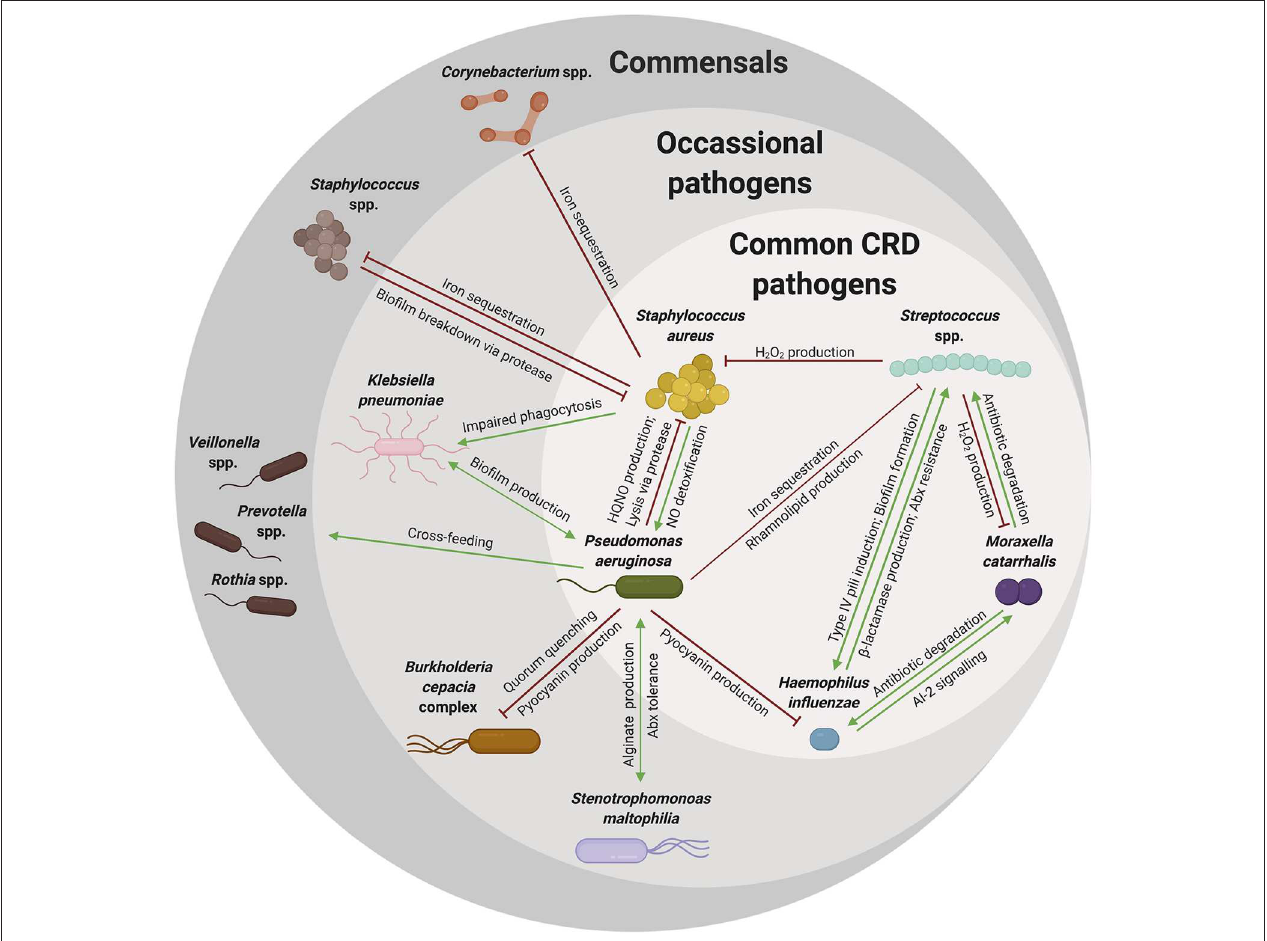
FIGURE 3 | A complex web of microbial interactions shape microbial communities. Many organisms reside in the respiratory tract of young patients with respiratory disease. However, as patients age, these communities become increasingly dysbiotic, likely due to interactions among colonizing organisms and newly acquired pathogens. Many interactions have been described between commensal organisms and pathogenic species that might explain the microbial community shifts noted over a patient’s lifetime. As illustrated here, many of these pathogens are shared among the various types of chronic respiratory diseases (common CRD pathogens), while other pathogens are not shared among all CRD, but rather indicated in one or few CRD (occasional pathogens), but still contribute to notable community shifts. Commensal species are also an important component of the respiratory microbiome, directly involved in competition with pathogenic species. Some of the cooperative (green arrow) and competitive (red) interactions described in this review are summarized in this web, with the arrow indicating directionality of effects. These interactions are diverse and likely complicated by respiratory symptoms and therapeutic strategies. Although complex, an understanding of these interactions can explain observed microbial shifts and may give us insight into overarching microbial community